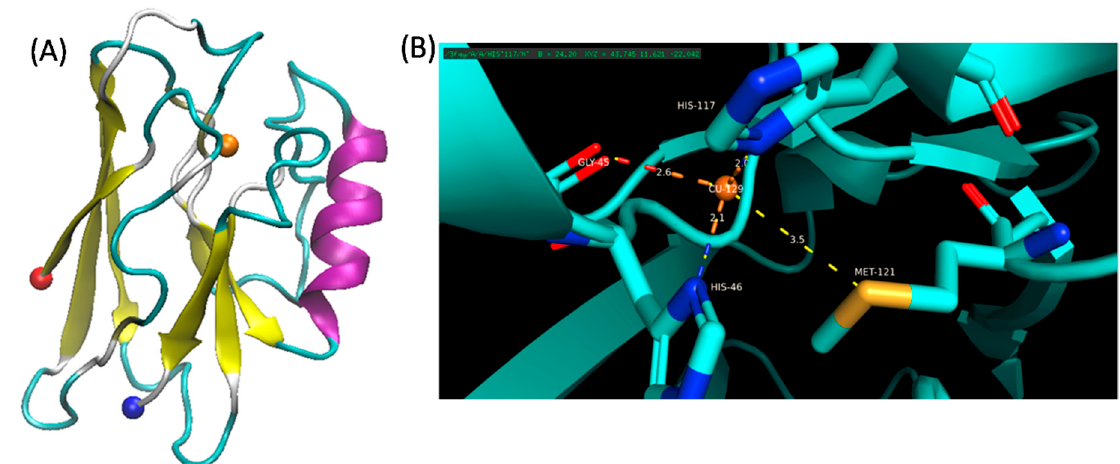
Figure 3. Structure of azurin from Pseudomonas areuginosa . The crystal structure was solved by Adman and Jensen; downloaded from rcsb.org (1AZU ([182]) [145] The structure was visualized using VMD. ( A ) 3D structure of azurin. The N- and C-termini are shown as red and blue spheres respectively while the copper is shown in orange (partially occluded in the structure). ( B ) Structural geometry of the copper shown in orange and chelating residues highlighted .